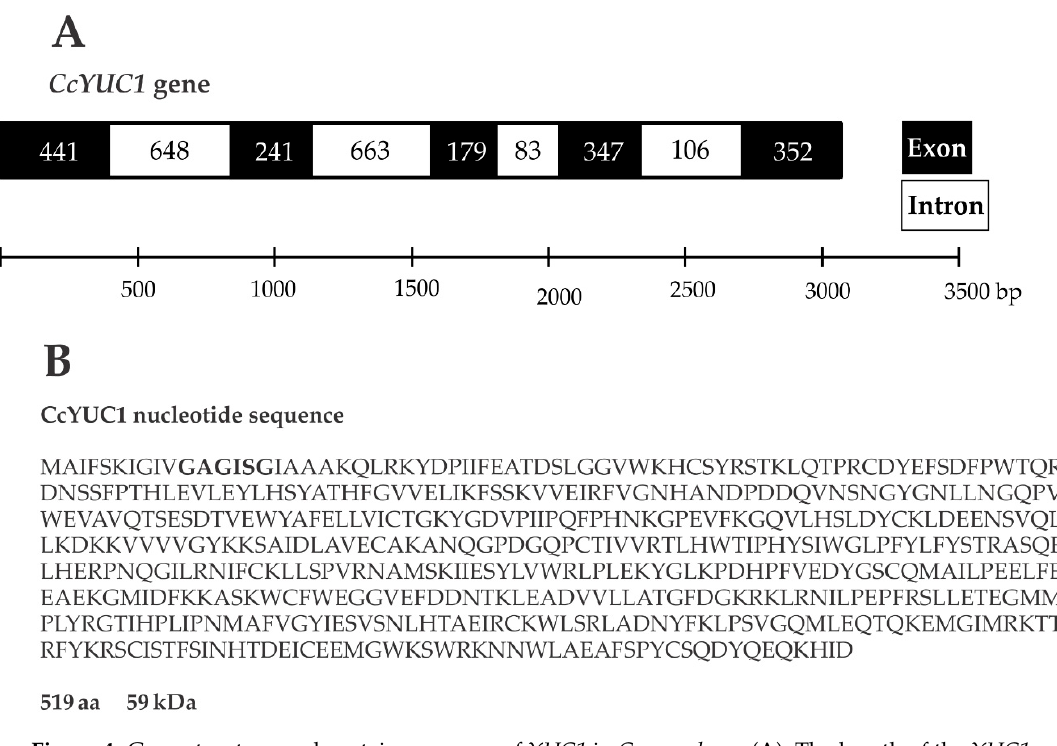
Figure 4. Gene structure and protein sequence of YUC1 in C. canephora . ( A ), The length of the YUC1 gene is 3060 base pairs, and the structure consists of five exons and four introns. ( B ), The YUC1 gene coding sequence produces a 519 amino acid protein with a molecular mass of 59 kDa. Bold letters indicate the FAD binding motif.